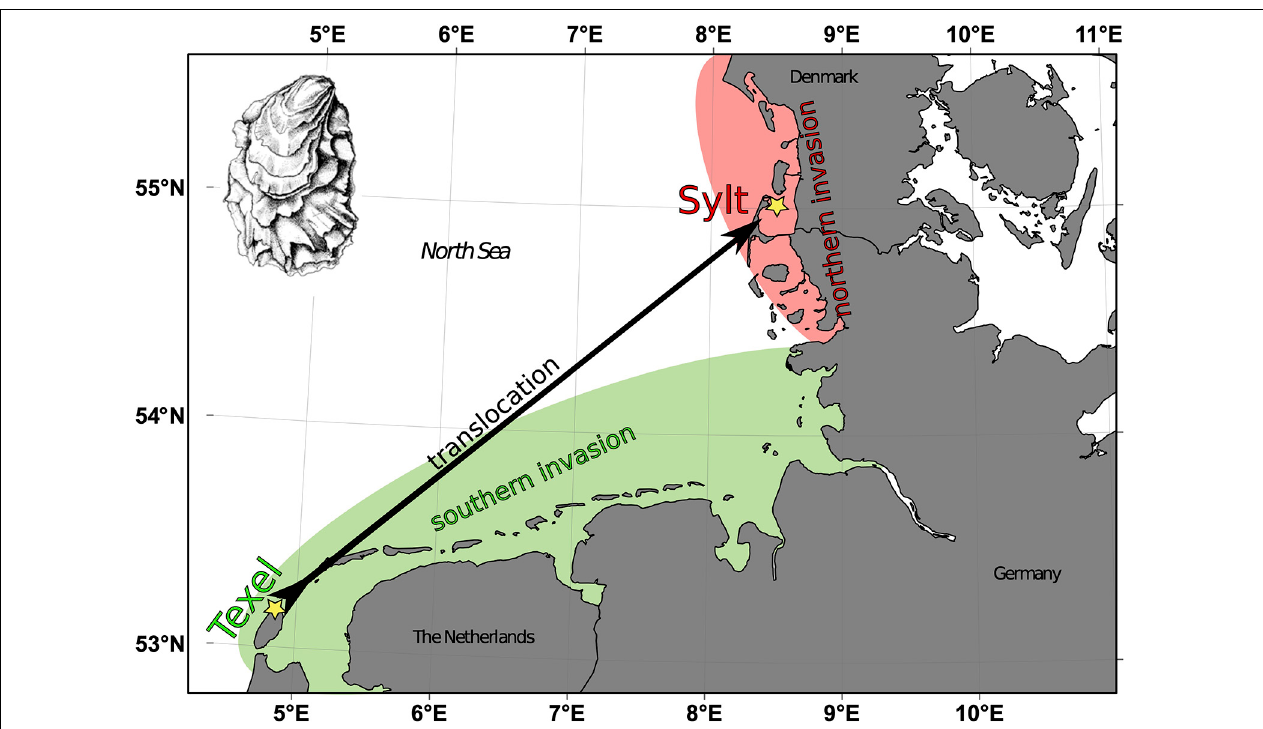
FIGURE 1 | Invasions of Pacific oysters Crassostrea gigas into the Wadden Sea. The southern invasion originated from aquaculture activities in the Oosterschelde and first feral oysters were found on Texel in 1983 (Bruins, 1983). The northern invasion was seeded by aquaculture activities on the island of Sylt where first wild oysters were found in the early 1990ies (Reise et al., 2017). Oysters from both original locations (yellow stars) served as representatives of the two invasion and genome wide differentiation was compared to transcriptomic differentiation of oysters from Texel that were translocated to Sylt.